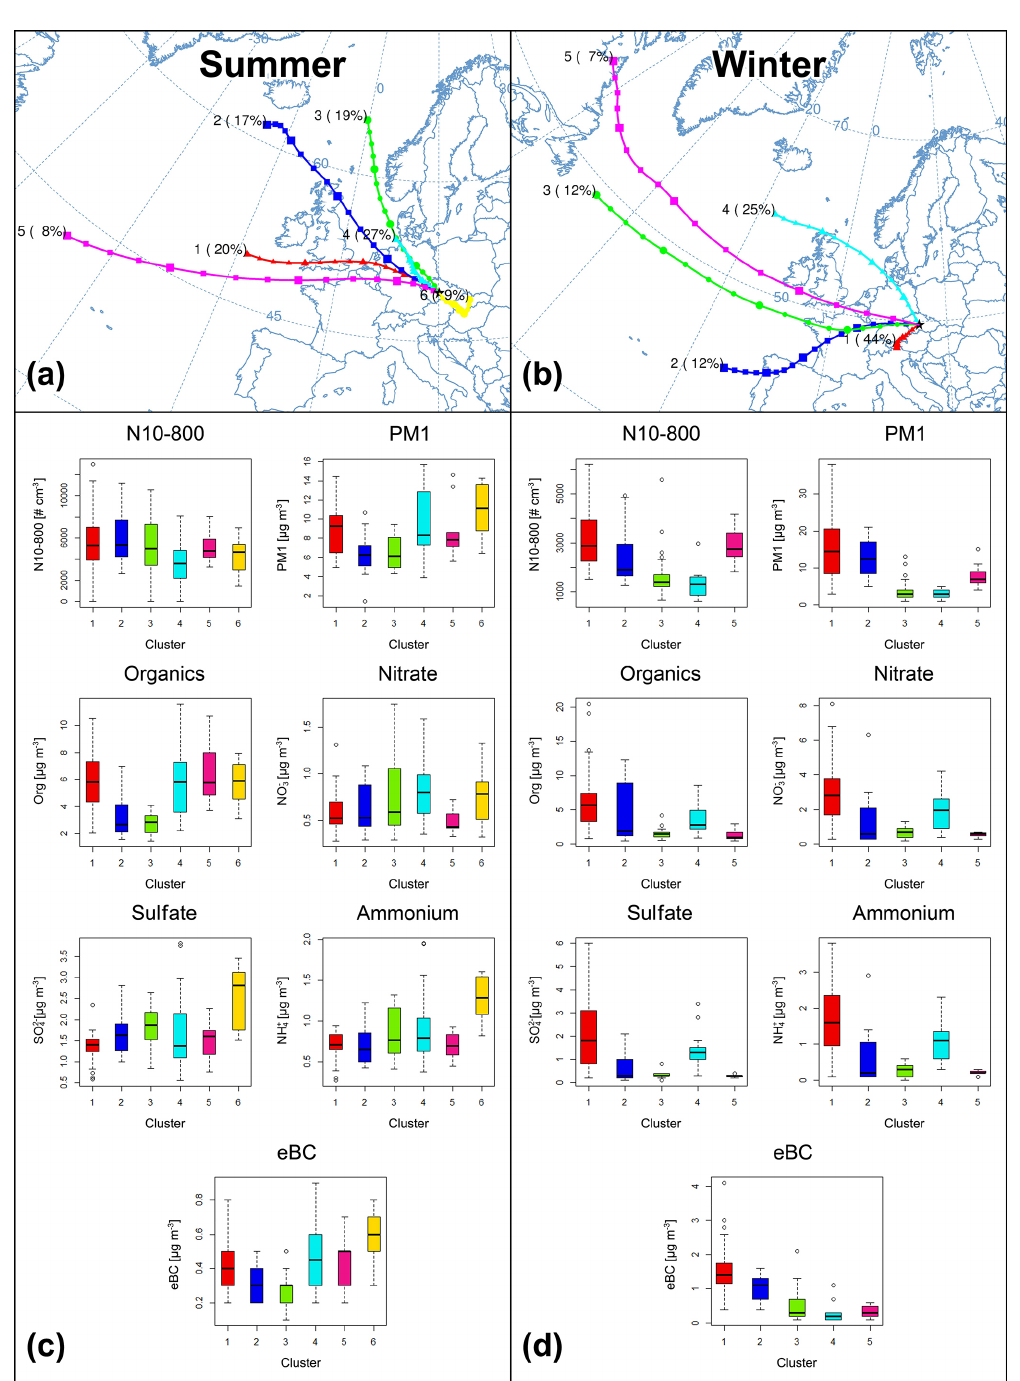
Figure 4. Geographical locations of the means of the clusters observed in summer (a) and winter (b) along with boxplots of the PM 1 , N10–800, organic, nitrate, sulfate, ammonium, and eBC concentrations in individual clusters measured during the summer (c) and winter (d) campaigns. The boxes are colour coded as the clusters, the black horizontal line is the median, the boxes border the 25th and 75th percentiles, and the whiskers represent 1.5 ×